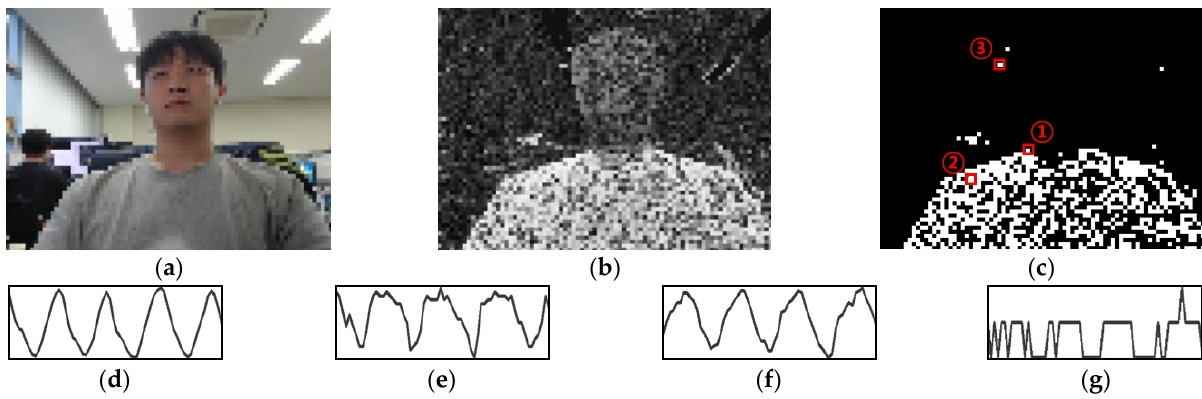
Figure 3. Labeling process for video using the reference and the variance in some pixels: ( a ) sample of a downsampled video; ( b ) correlation coefficient calculated from the video and reference signal; ( c ) label for the video ( T = 0.7); ( d ) reference signal; ( e – g ) variance of Pixels 1–3, respectively.